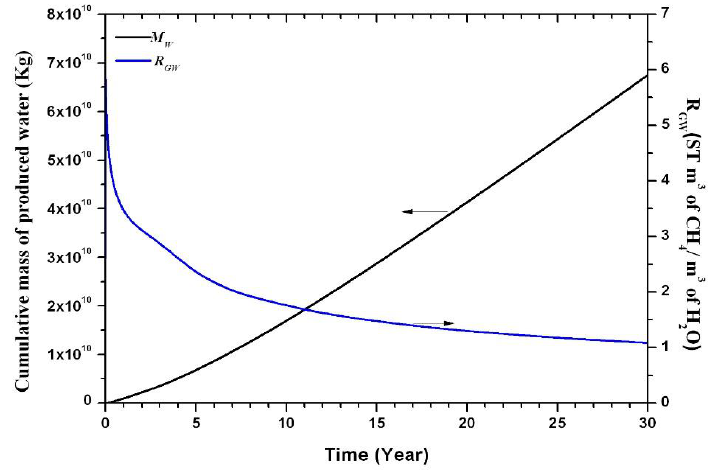
Figure 8. Reference case: evolution of the cumulative mass of produced water ( M w ) and gas to water ratio ( R GW ) overtime.